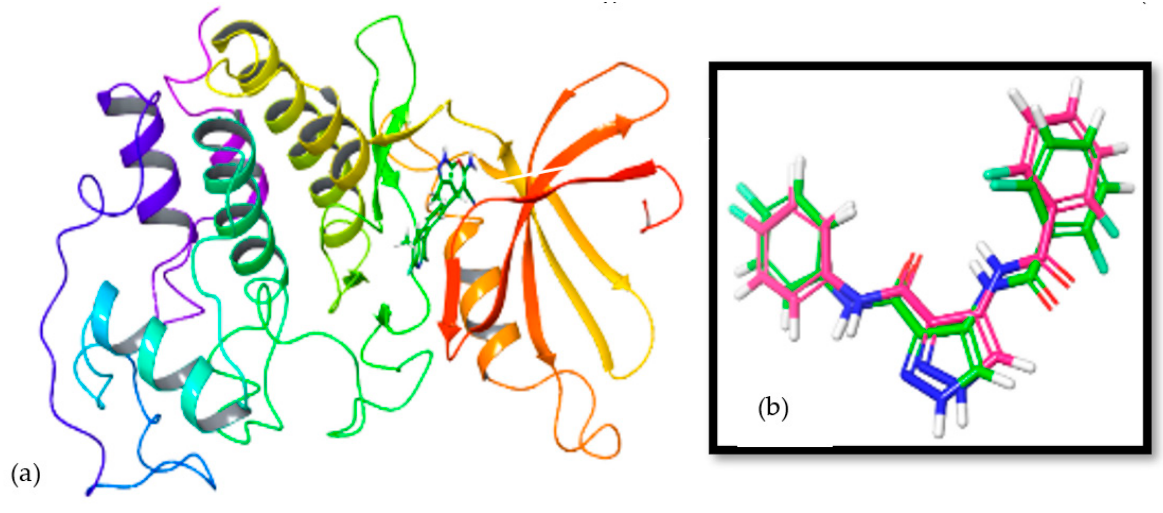
Figure 5. Cartoon representation of the CDK1 and compound 5b ( a ). 3D representation of the pre- dicted binding mode (in green) and experimental structure (in magenta) of co-crystallized ligand ( b ).